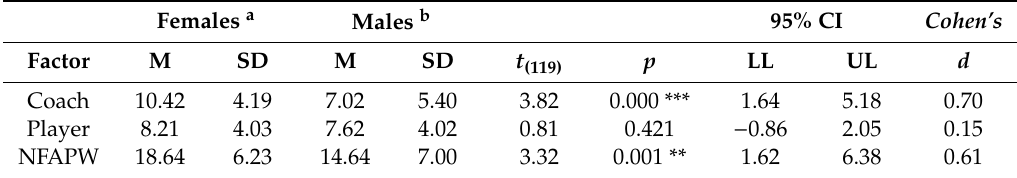
Table 5. NFAPW, coach dimension, and player dimension scores according to gender.